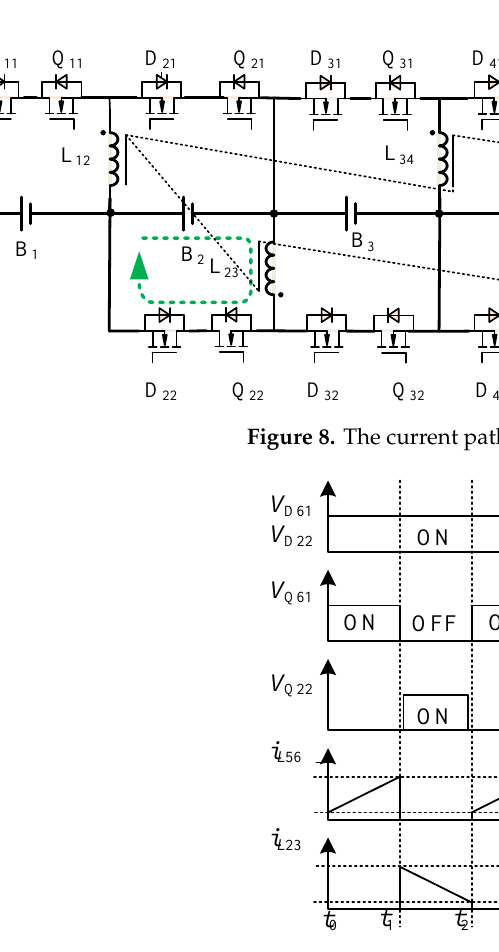
Figure 9. Key waveforms of Case 2.